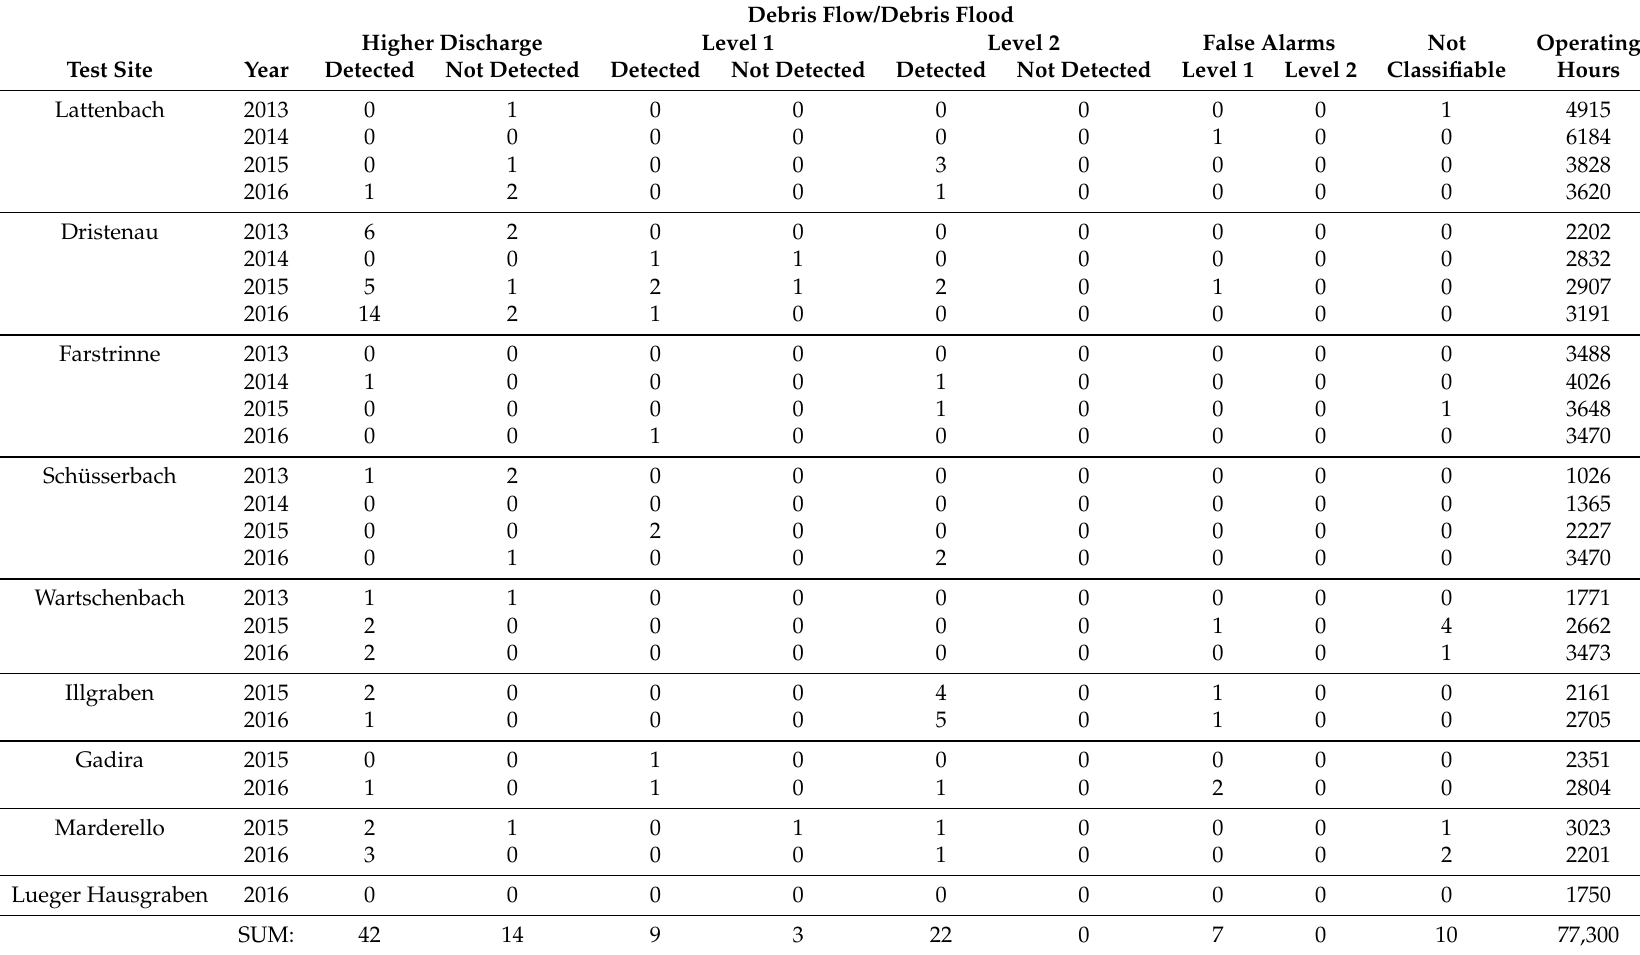
Table 3. Events, detections and false alarms from 2013 to